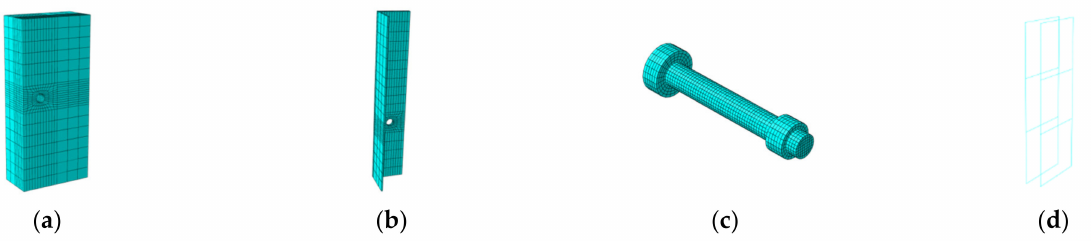
Figure 2. Mesh details and element types of the numerical model: ( a ) concrete block C3D8R; ( b ) steel girder C3D8R; ( c ) bolt shear connection C3D8R; ( d ) reinforcing bars